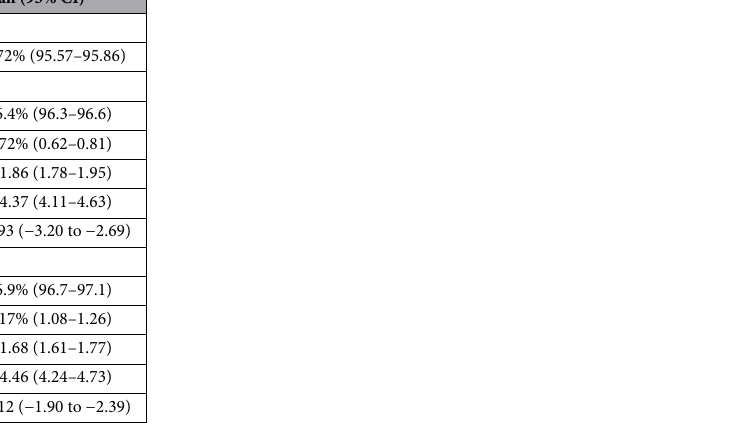
Table 2. Bias and precision for each pulse oximeter (n = 10 000). CI confidential interval, SaO 2 arterial oxygen saturation, SpO 2 pulse-oximetric oxygen